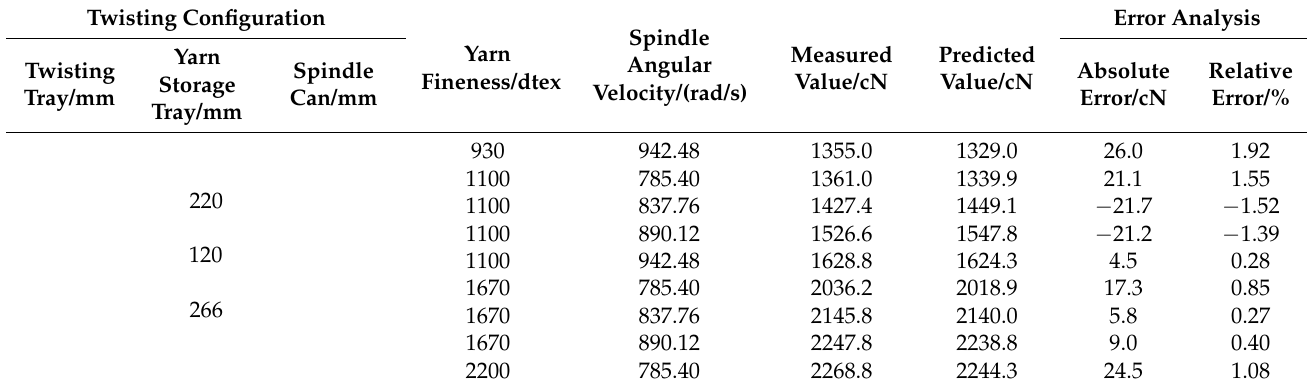
Table 5. Measured and predicted twisting tension error